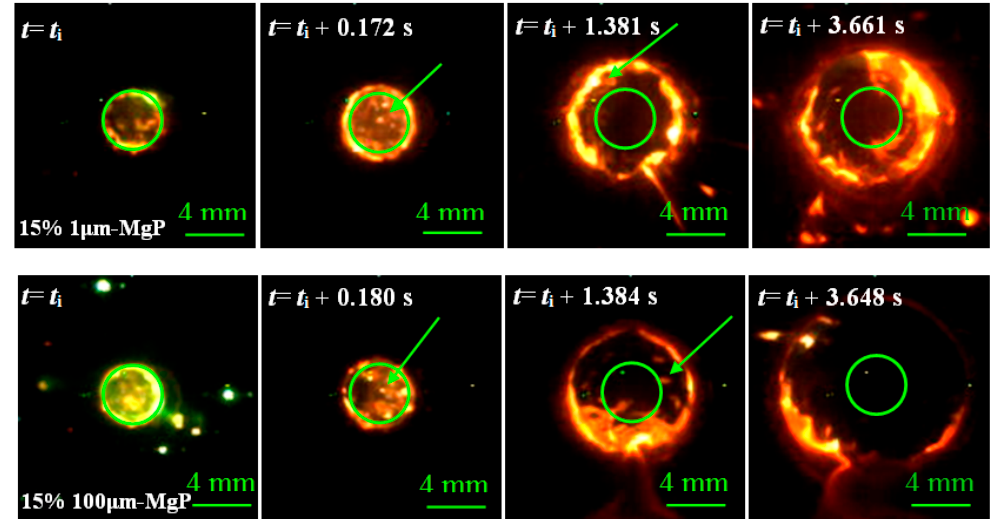
Figure 11. Combustion surface regression process of small ( top ) and large ( bottom ) magnesium particles/paraffin composite fuels.